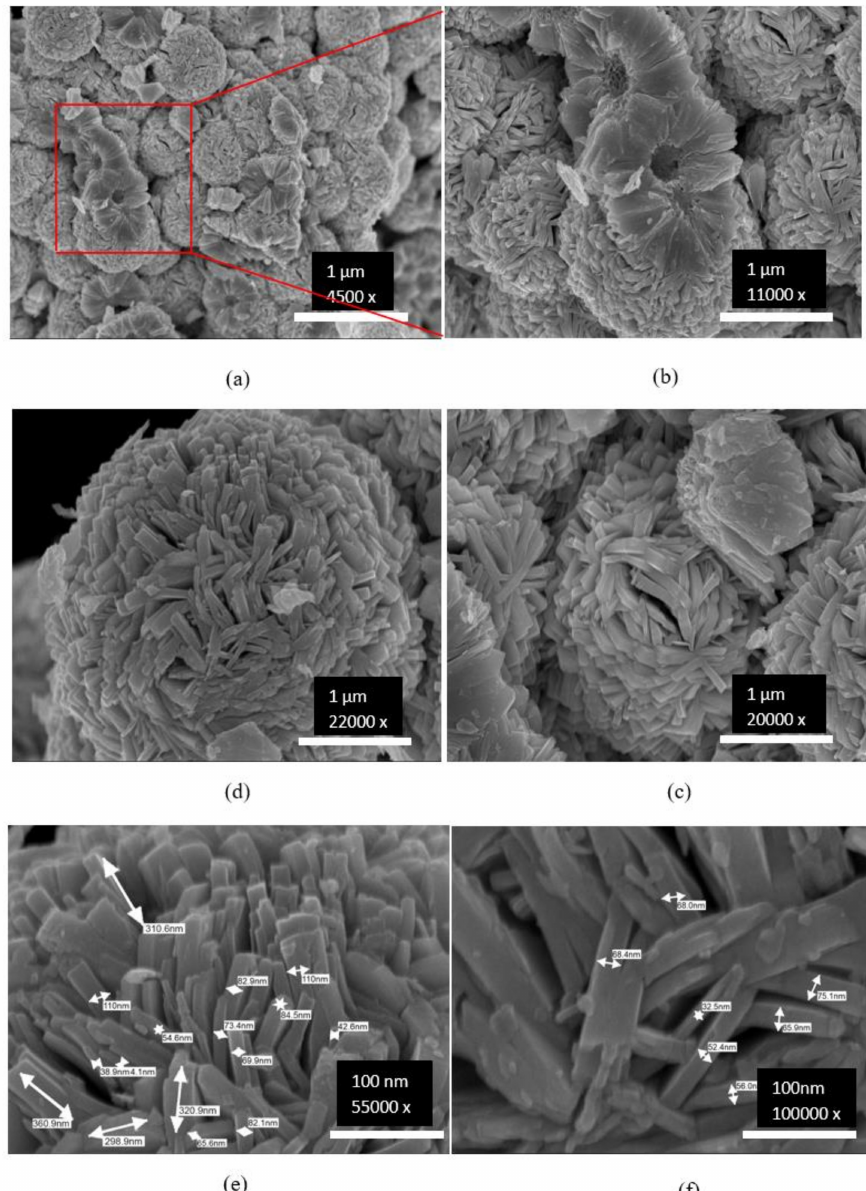
Figure 18. ( a – d ) Scale images (1 µ m) of tungsten oxide particles at 4500 × , 11,000 × , 20,000 × and 22,000 × magnification view, respectively. ( e , f ) Scale images (100 nm) of tungsten oxide at 55,000 × and 100,000 × magnification, respectively, along with its three-dimensional average size